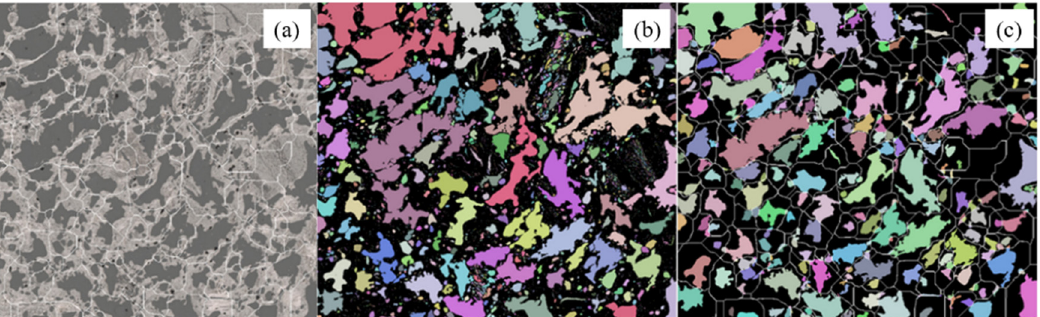
Figure 10. Pore automatic segmentation process: ( a ) the pore separation lines; ( b ) different pores with colors; ( c ) porosity color map after separation [78].